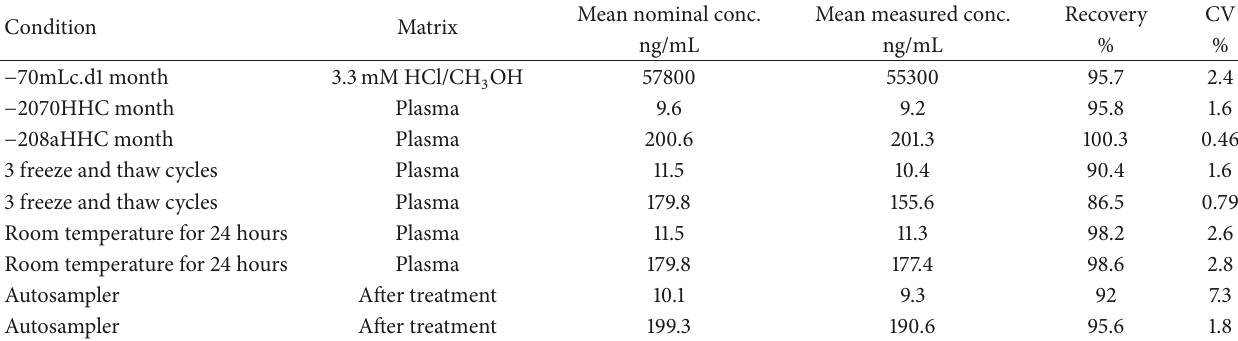
Table 1: Stability of lenvatinib in human plasma and stock